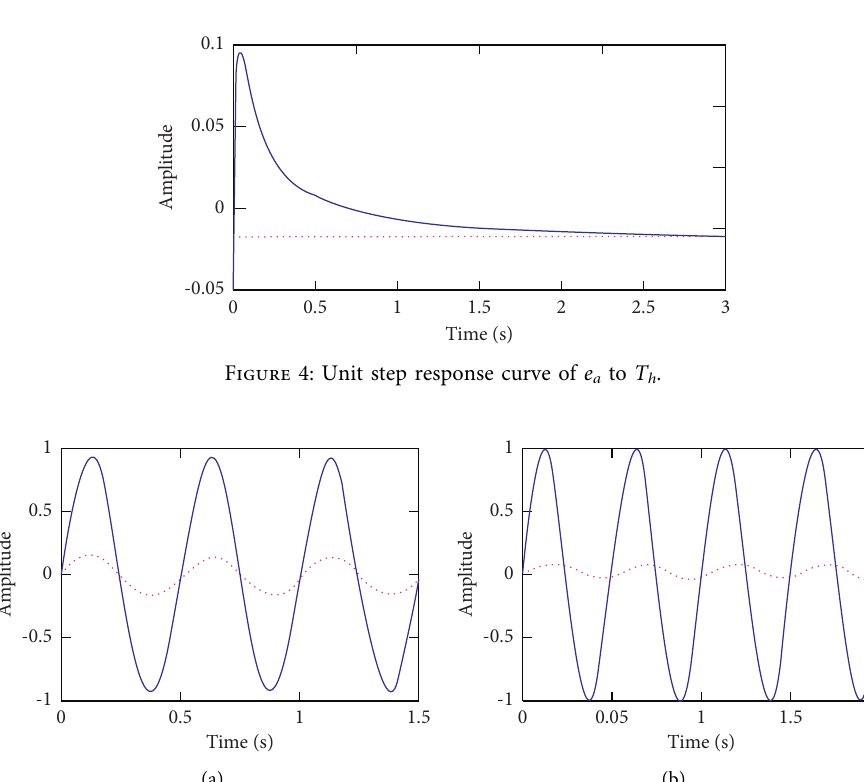
Figure 5: Sine response curve of e a to T h . (a) 2 Hz response of input hand torque and (b) 20 Hz response of input hand torque.